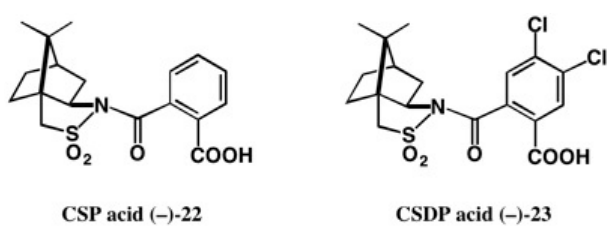
Figure 16. Chiral ( − )-CSP and ( − )-CSDP acids useful for alcohols.